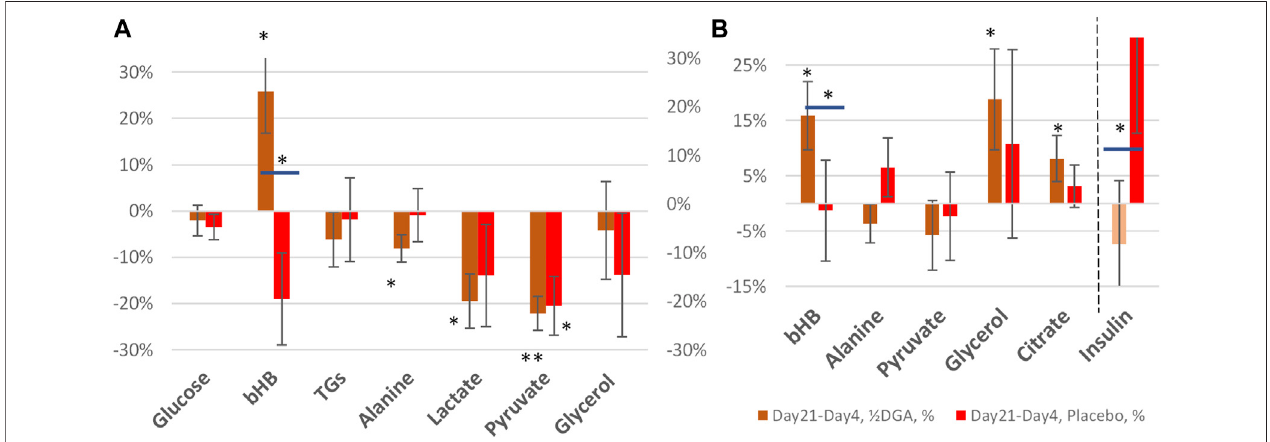
FIGURE 4 | 21 days (A) and 14 days (B) %-changes in selected plasma energy metabolites and insulin. Statistical tests are based on intra-individual changes. In Figure4A thechangesarefromDay0andin Figure4B fromDay4.HorizontalbarsinbHBandInsulinindicatestatisticallysigni fi cantdeviationbetweentheplaceboand DGA